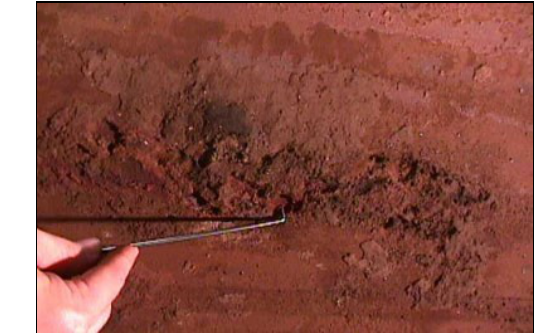
Figure 9 – Corrosion pitting on the inside of the pipe near the rupture site Рис . 9 – Питтинговая коррозия на внутренней стенке трубы в зоне